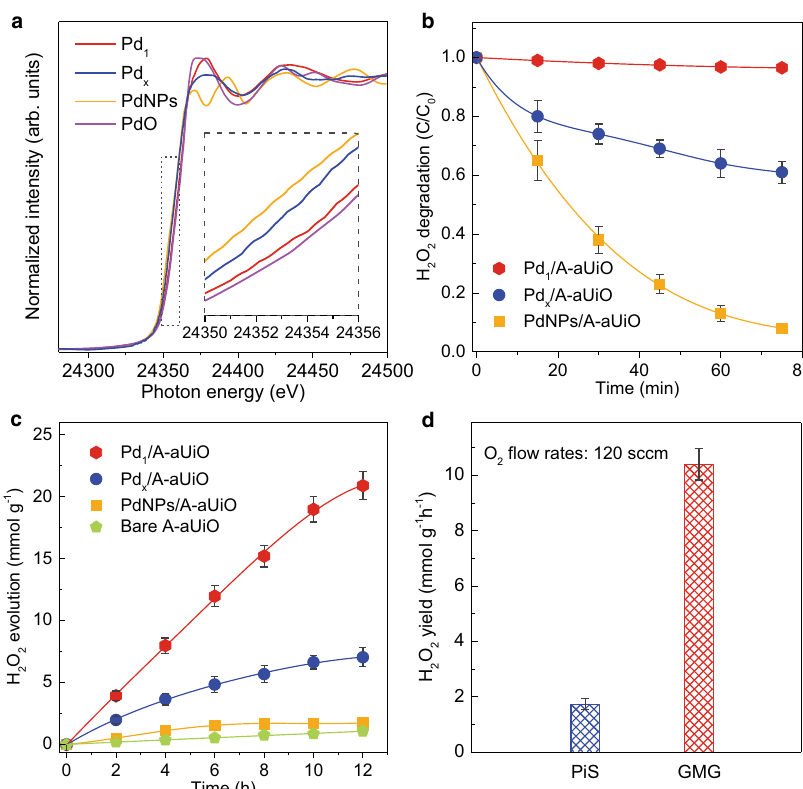
Fig. 4 Photocatalytic O 2 reduction (ORR) on Pd modi fi ed MOF powders and membrane. a Pd K-edge XANES spectra of PdNPs, Pd x , and Pd 1 decorated A- aUiO catalysts. PdO was used as standard. b Time course of H 2 O 2 decomposition on PdNPs, Pd x , and Pd 1 decorated A-aUiO catalysts. c Time course of H 2 O 2 generation on pristine A-aUiO and PdNPs, Pd x , and Pd 1 decorated A-aUiO catalysts. d H 2 O 2 yields on Pd 1 /A-aUiO particles (PiS) and membranes (GMG), respectively. All the photocatalytic reactions were performed under visible light (>420 nm) irradiation and using isopropanol (20 v/v% in water) as sacri fi cial agents. The O 2 fl ow rates were fi xed at 120 sccm. Error bars represent the standard deviation for three independent catalysis